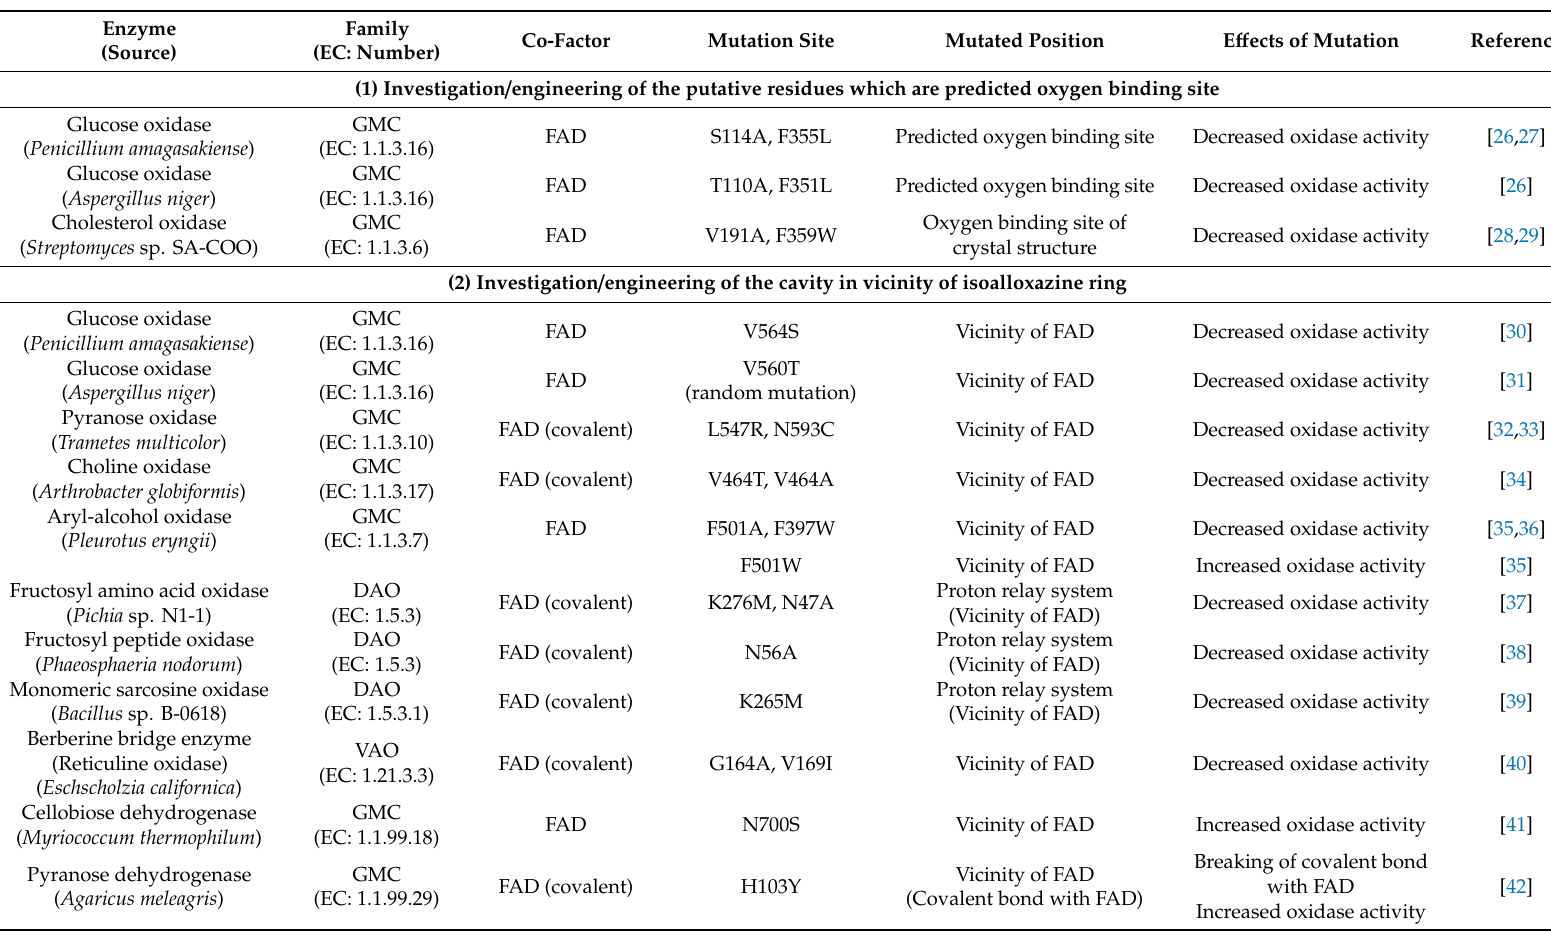
Table 1. The investigation / engineering the oxidative half-reaction of flavin-dependent oxidases and dehydrogenases with oxygen as the electron acceptor. Enzyme